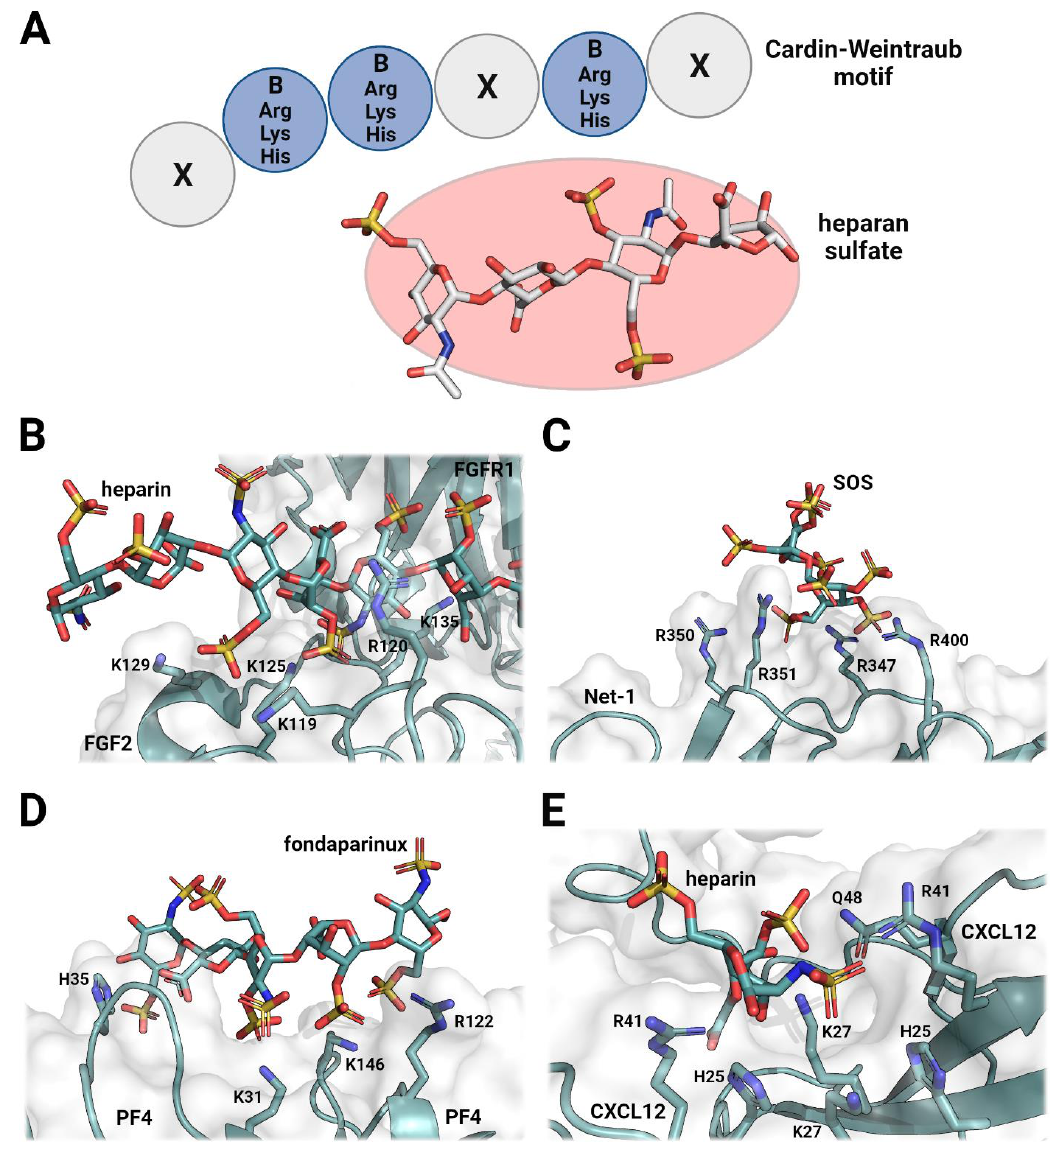
Figure 1. Structural examination of heparan-sulfate-based ligands and their respective protein binding sites. Protein–ligand interactions mostly occur over arginine and lysine residues, which form various protein surface interfaces. Some other contributing residues include histidine and glutamine, which stabilize the complexes through additional electrostatic or hydrogen-bonding interactions. This results in amino acid variations, which have drastic effects on the affinity and specificity of heparan sulfate or heparin ligands. ( A ) Schematic of the XBBXBX Cardin–Weintraub motif and its potential interactions with a heparin ligand. Protein–ligand interaction mostly occurs through electrostatic forces between positively charged (blue) amino acid side chains and negatively charged (red) sulfate groups on heparin. ( B ) Fibroblast growth factor 2 (FGF2) in complex with fibroblast growth factor receptor 1 (FGFR1), which is mediated by a long-chain heparin ligand (PDB ID: 1FQ9) [25]. ( C ) Netrin-1 (Net-1) in complex with sucrose octasulfate (SOS) (PDB ID: 7LRF) [32]. ( D ) Platelet factor 4 (PF4) in complex with the heparin mimetic fondaparinux (PDB ID: 4R9W) [33]. ( E ) Stromal-cell-derived factor 1 (CXCL12) bound to a heparin disaccharide (PDB ID: 2NWG) [34].